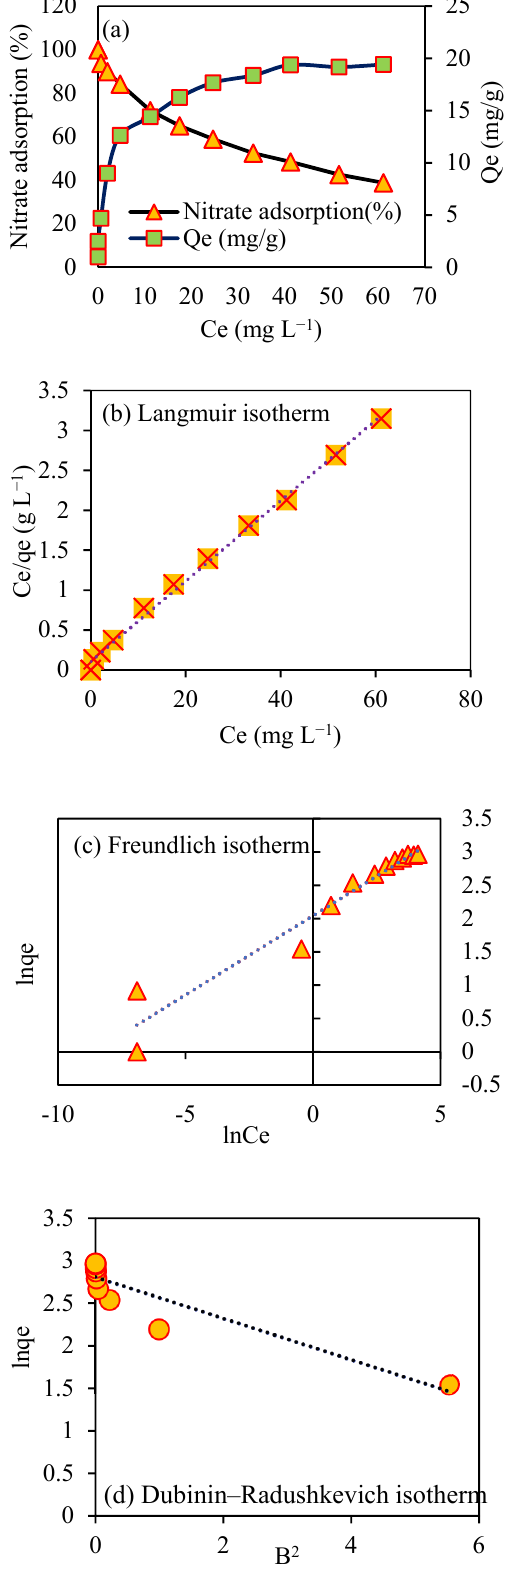
Figure 9. Effect of initial concentration of nitrate on ( a ) adsorption and the adsorption isotherm models of ( b ) Langmuir, ( c ) Freundlich, and ( d )